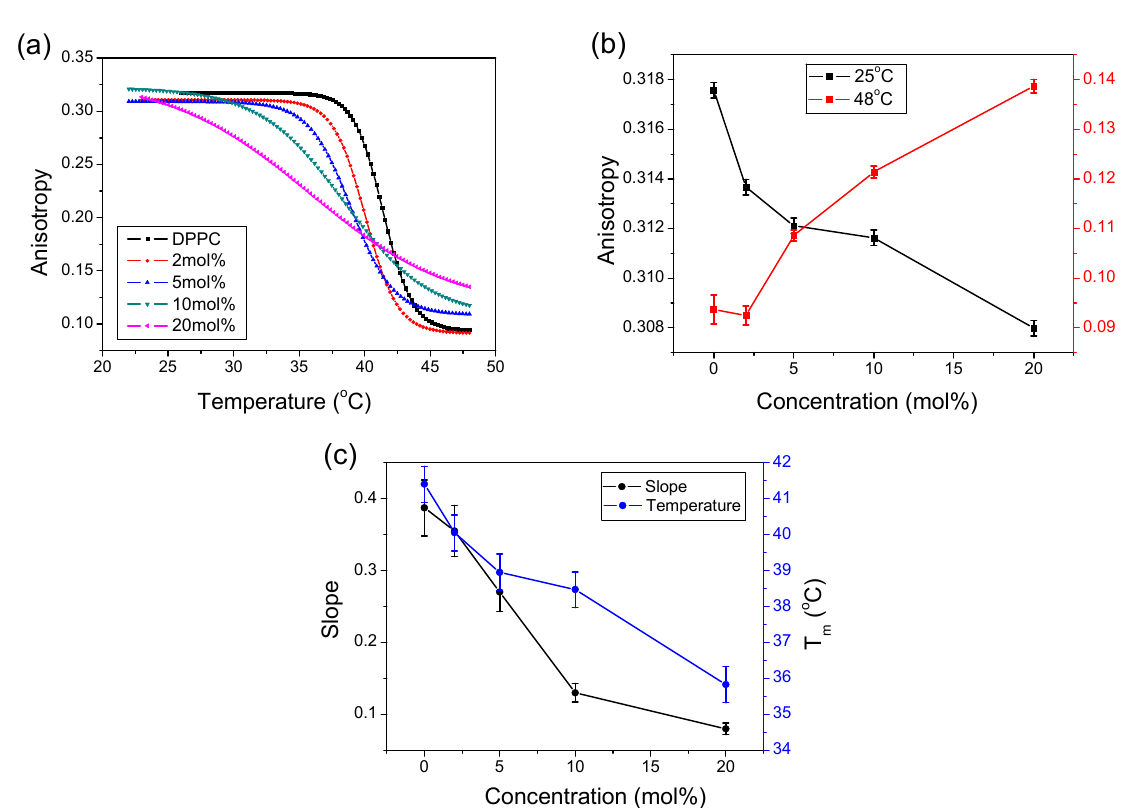
Figure 3. Effect of CT on DPH anisotropy in DPPC liposome: ( a ) temperature profiles of DPH anisotropy in 0.08 mg/mL DPPC at increasing concentrations of CT are given in the legend; ( b ) changes in DPH anisotropy in the gel phase at 25 °C and in the liquid crystalline phase at 48 °C; ( c ) plot of parameters fitted to Equation (1); T m , the temperature of the phase transition (right axis) and the slope (left axis). Δ T = 0.5 °C.